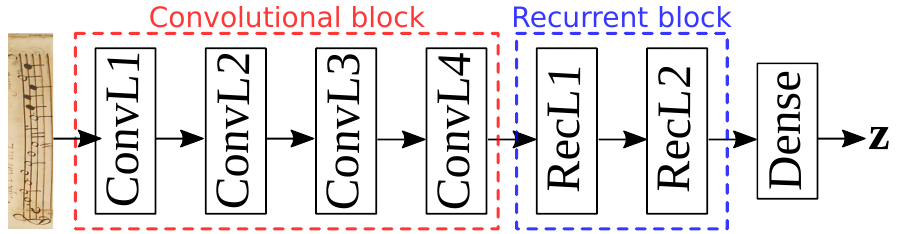
Figure 2. Graphical scheme of the CRNN configuration by Calvo-Zaragoza et al.